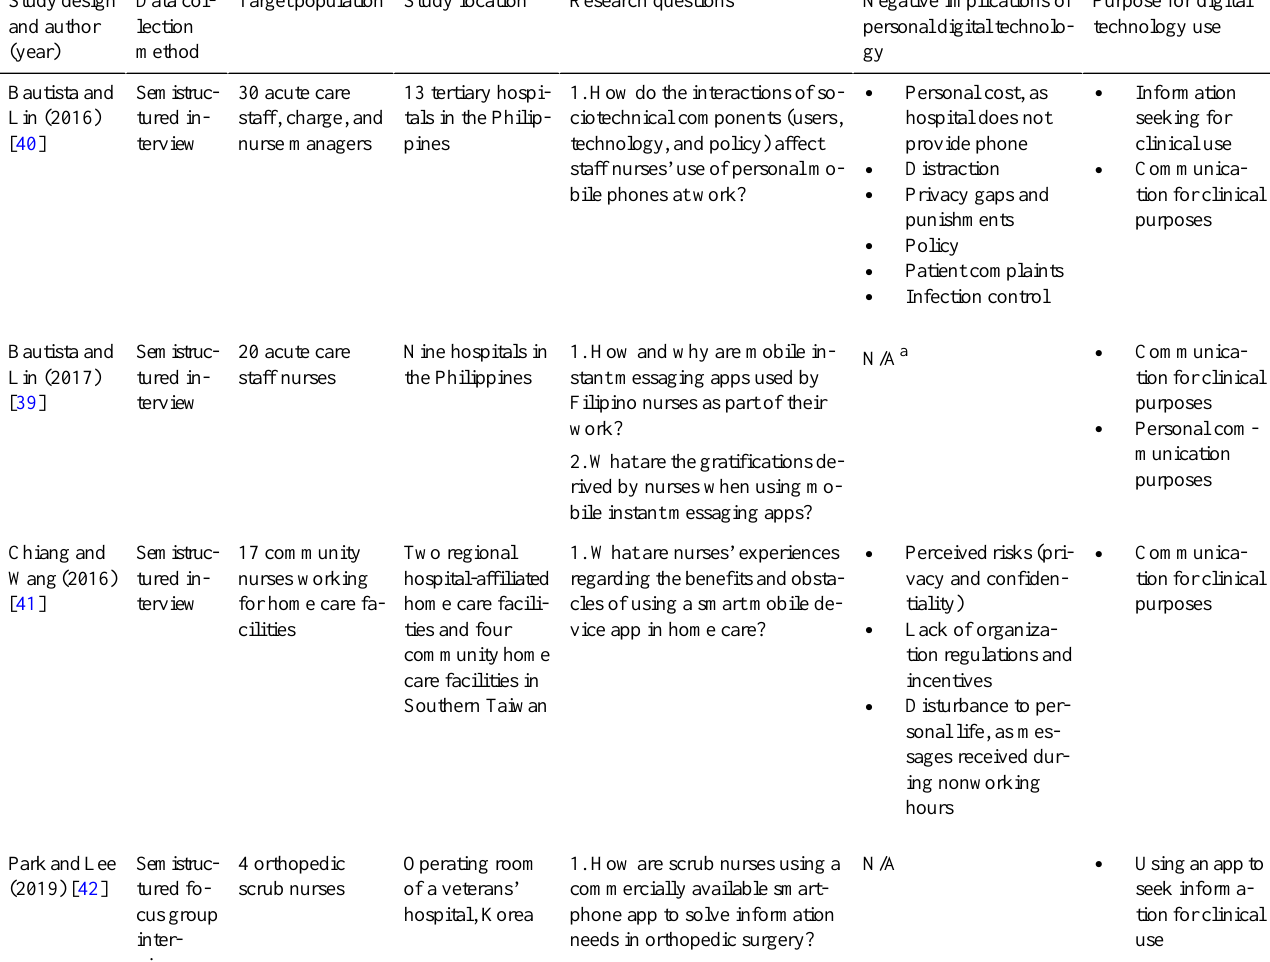
Table 2. Included qualitative